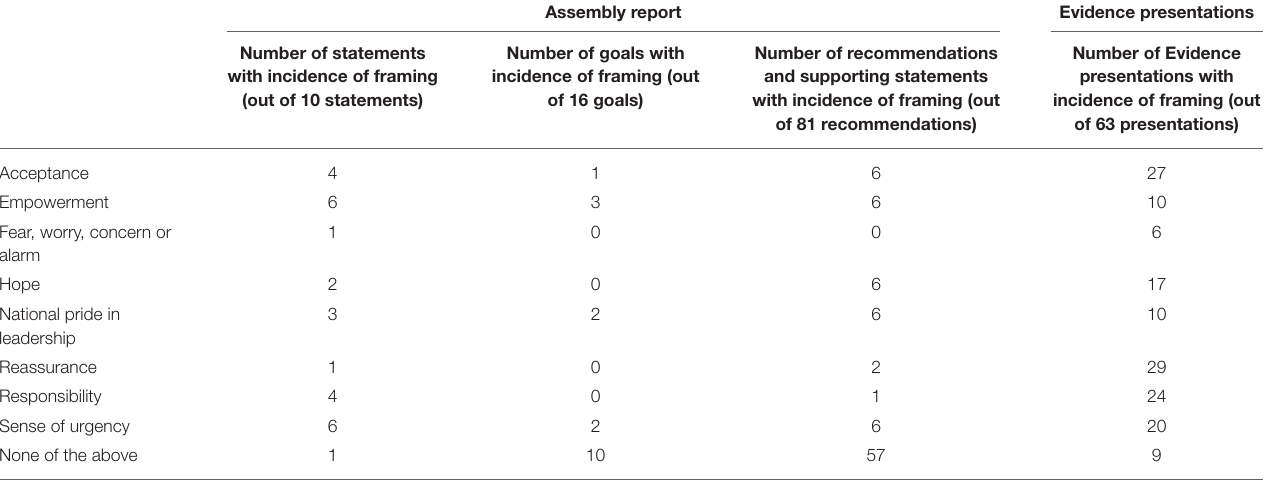
TABLE 5 | Emotional content of assembly report and evidence